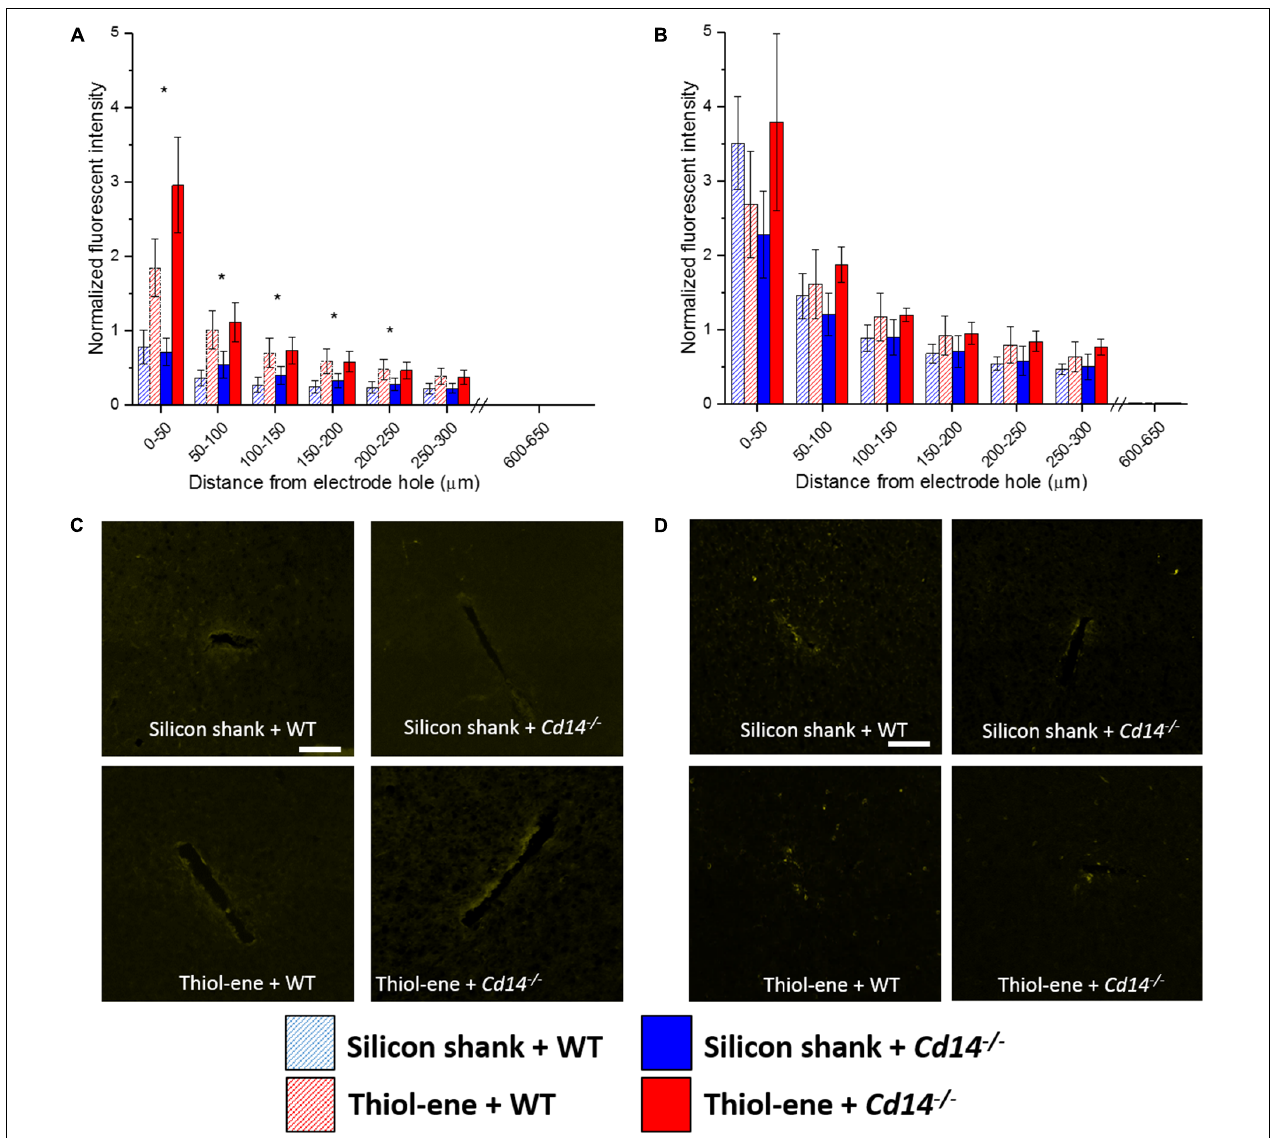
FIGURE 5 | Immunohistochemical evaluation of blood-brain barrier permeability. Blood–brain barrier permeability evaluated as IgG expression with respect to distance from the explanted microelectrode hole ( µ m). (A) 2 weeks. (B) 16 weeks. (C) Representative images of 2 weeks BBB permeability. (D) Representative images of 16 weeks BBB permeability. Scale bar: 100 µ m. ∗ Denotes significance between silicon and thiol-ene